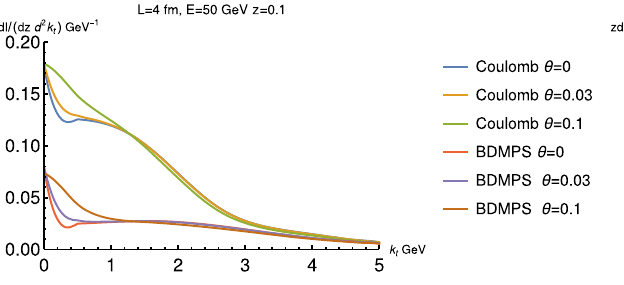
Fig. 5 The angular distributions z dI for different θ = 0 , 0 . 03 , 0 . 1 latedintheharmonicoscillatorapproximationbutincludingfinitegluon dzd 2 k t energy, Coulomb means the angular distribution in the Moliere the- for E = 50 GeV (corresponding to massless, charmed and bottom ory (i.e. BDMPS+Coulomb Logarithms) calculated taking into account quarks). As above BDMPS means the angular gluon distribution calcu- finite gluon energy.